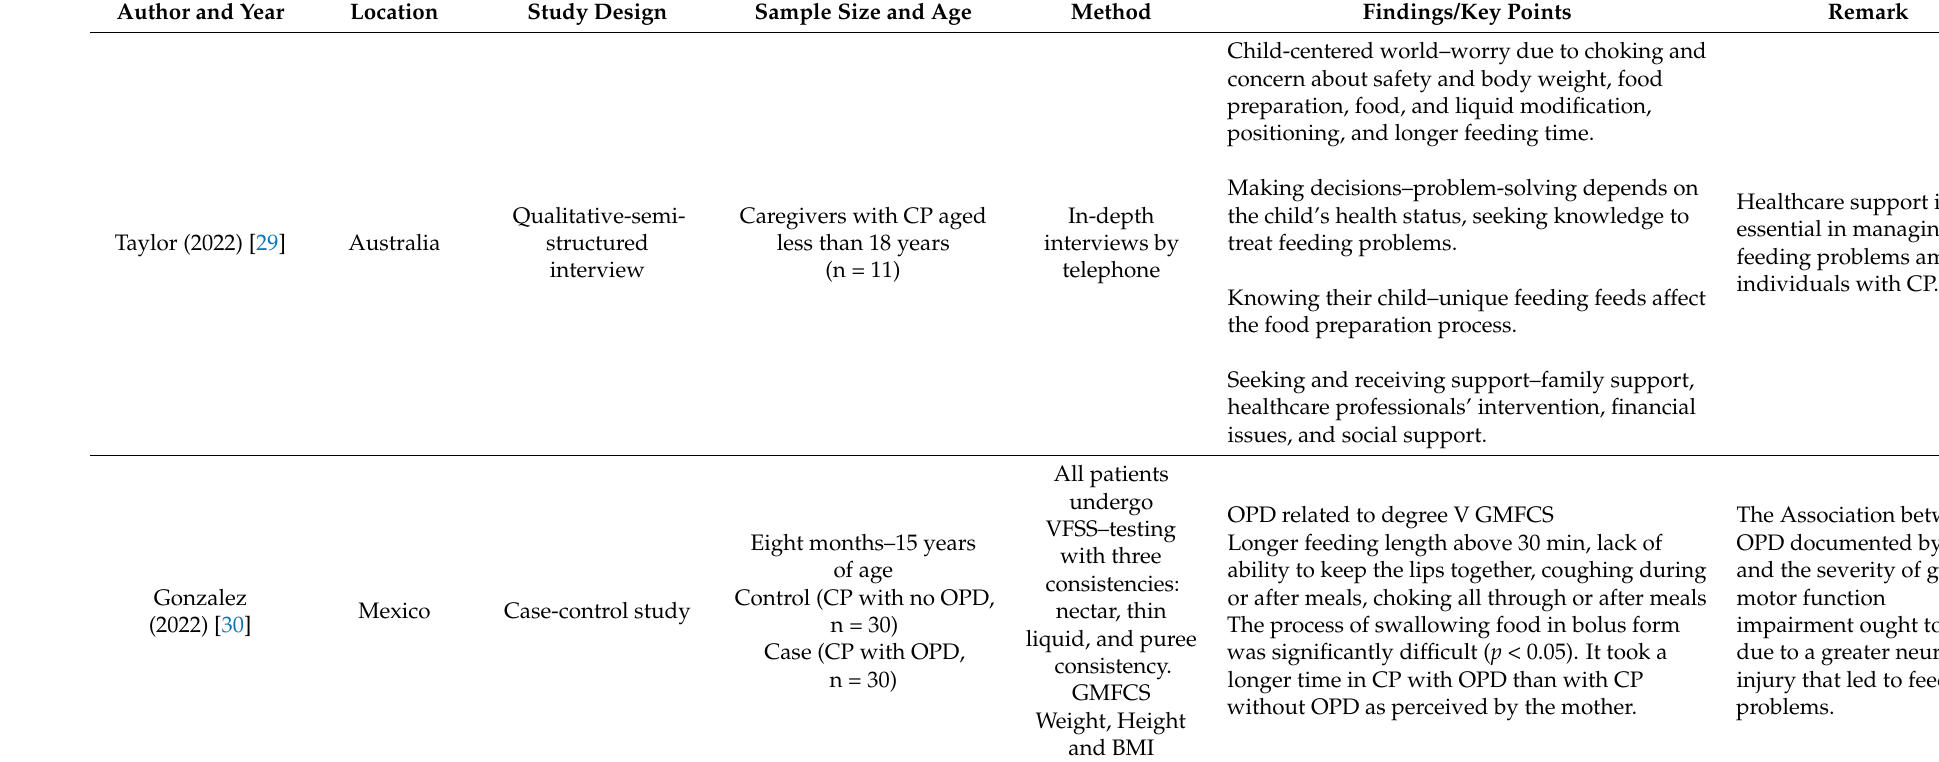
Table 3. Challenges faced by individuals and families with cerebral